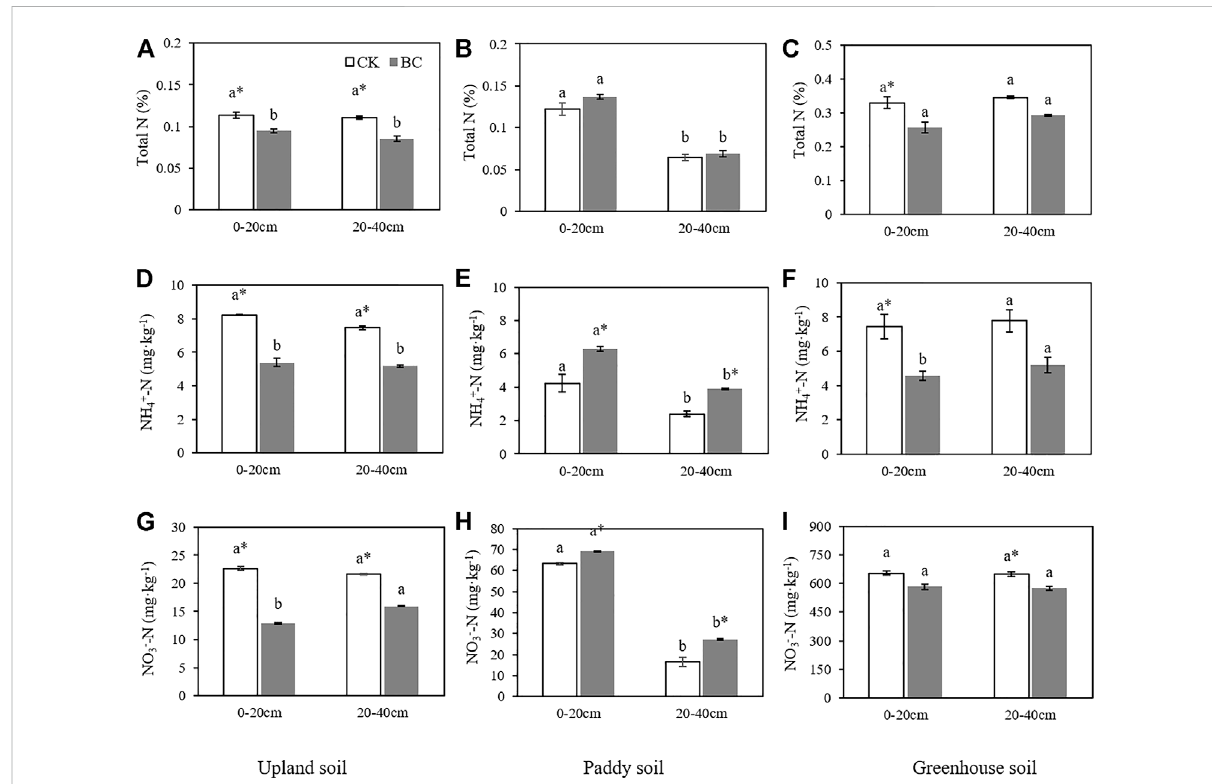
FIGURE 1 The soil total N (TN), NH 4 + -N and NO 3 − -N concentrations in the control and biochar-amended soils upland soil (A,D,G) ; paddy soil (B,E,H) ; greenhouse soil (C,F,I) . Bars represent the standard error of the mean. Different lowercase letters indicate signi fi cant differences between the 0 – 20 and 20 – 40 cm soil layers, the * and ** indicate signi fi cant differences between the control and biochar treatments within the same soil depth based on an independent t test at p < 0.05 and 0.01,